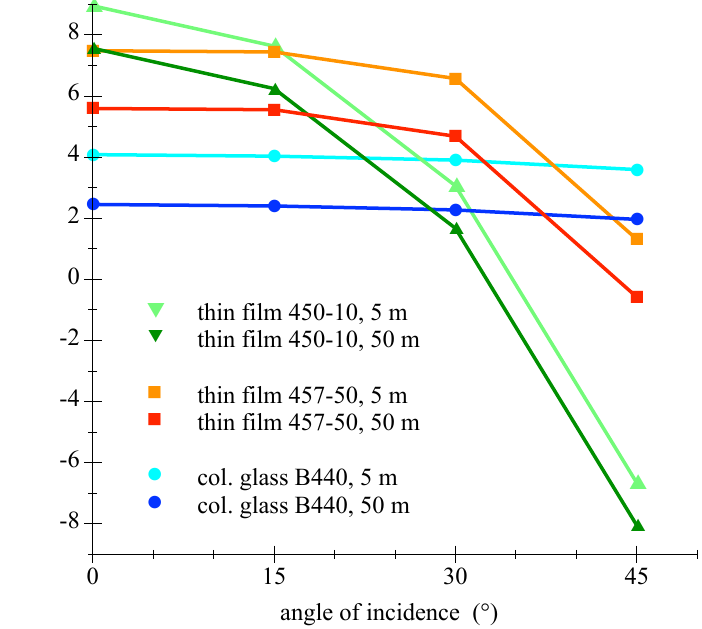
Figure 17. Graphics is showing the change in OSNR as function of the AOI for three different filters at two water depths in water type III (intermediate clear, coastal